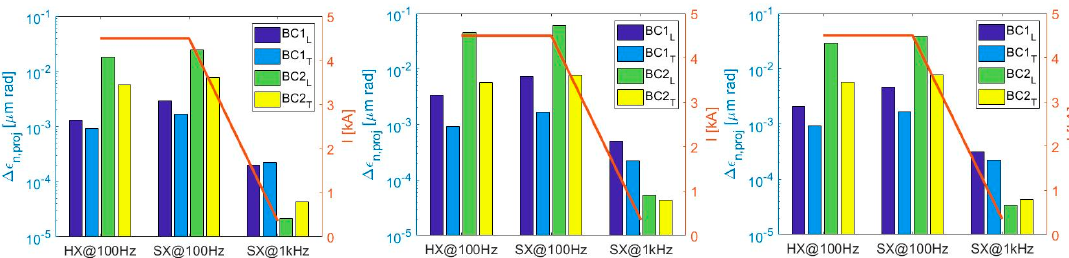
Figure 5. Horizontal normalized projected emittance growth from CSR longitudinal (L) and transverse (T) field in BC1 and BC2, for the bunch charge of 75 (left), 150 (middle) and 300 pC (right). See text for details.